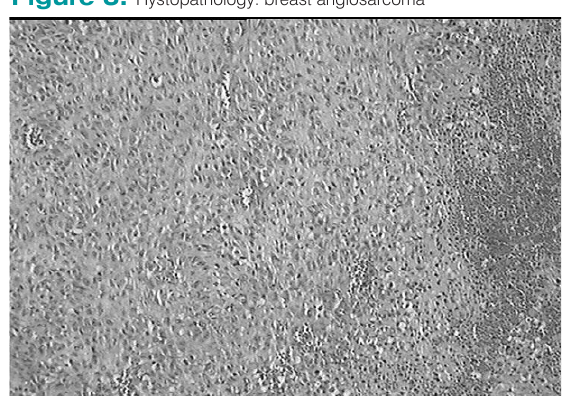
Figure 3. Hystopathology: breast